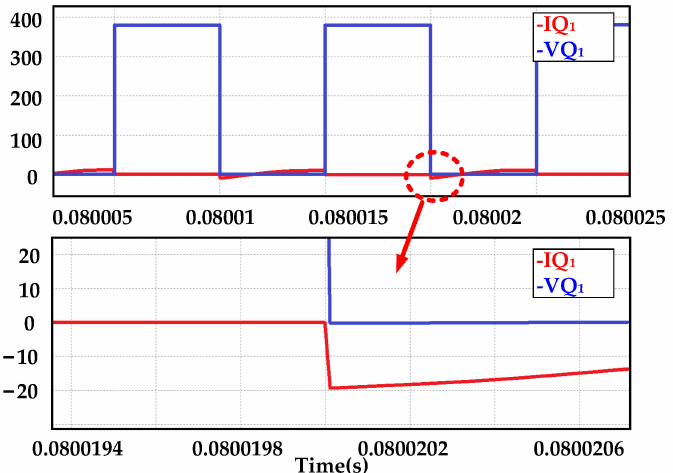
Figure 12. Current waveform and voltage waveform of Q 1 in WPT system without optimization.